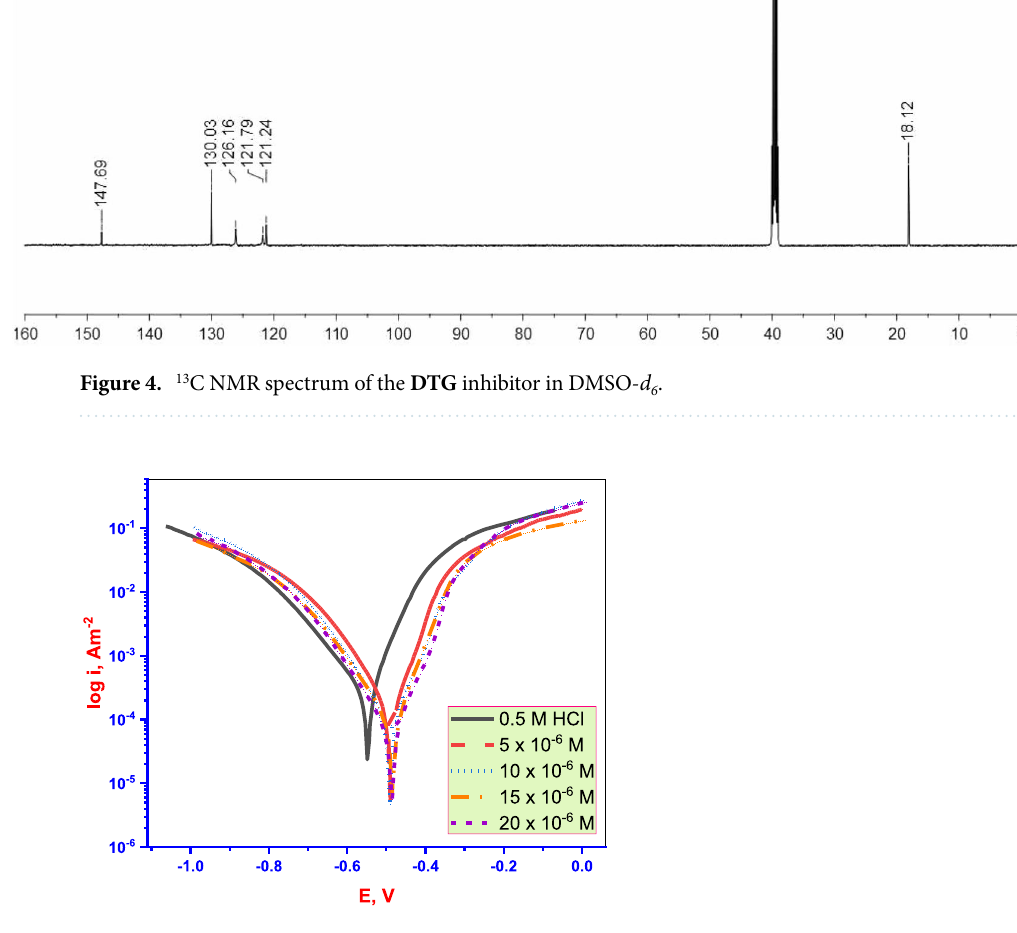
Figure 5. PDP curves for Cu in test solutions with/without of DTG .